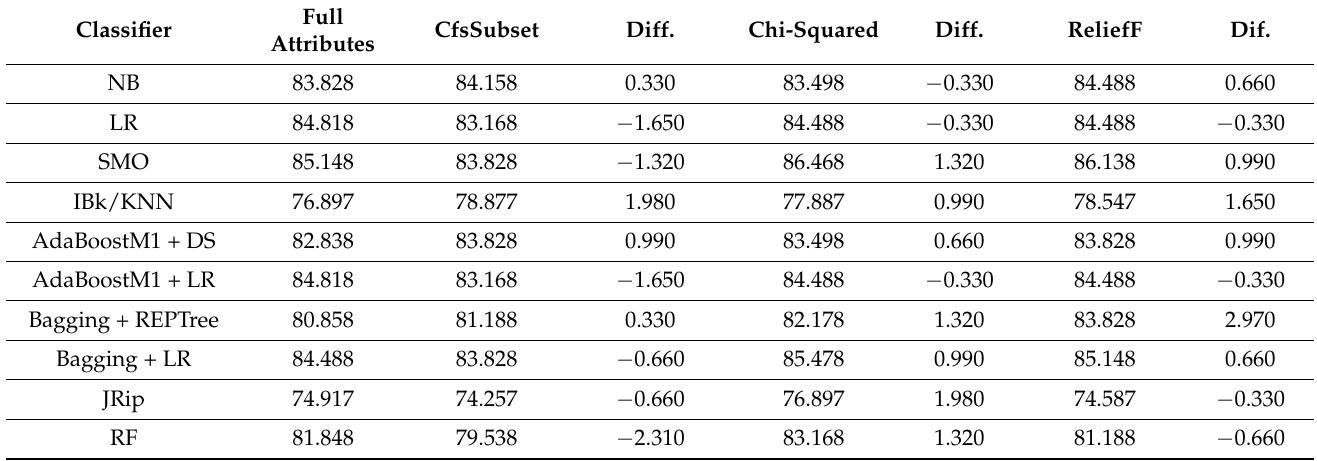
Figure 10. Performance metrics based on the optimal set obtained using the ReliefF attribute evaluation. A comparison of the accuracy values using the full set of attributes of the Cleveland dataset and optimal attribute sets obtained using various attribute selection techniques performed in this work is shown in Table 11. The correlation-based feature selection method was not able to provide an accuracy value greater than that of the full attribute space. However, there was an improvement in accuracy of about 2% and 1% from the IBk and AdaBoostM1 + DS classifiers, respectively. Besides providing the highest accuracy of 86.468% from SMO, the chi-squared attribute evaluation technique improved most of the classifiers’ performances, except for the NB, LR, and AdaBoostM1 + LR classifiers. An increase in the accuracy of about 2% was attained using the JRip algorithm and 1% using the IBk and Bagging + LR algorithms. The ReliefF attribute evaluation method offered the highest improvement in accuracy of about 3% when using the bagging + REPTree classifier, followed by 1.65% from the IBk classifier and about 1% from the SMO and AdaBoostM1 + DS classifiers. Table 11. Accuracy comparison of the attribute selection techniques.